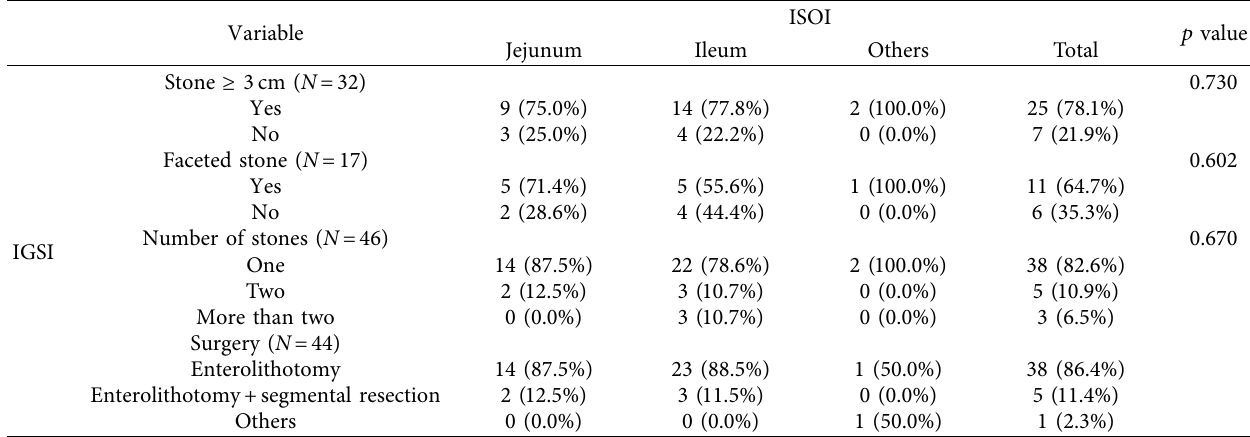
Figure 3: Time of recurrence, (a) ISOI ( p � 0 . 73 ) , (b) number of stones ( p � 0 . 27 ) , (c) age groups in years ( p � 0 . 96 ) , and (d) size of stones ( p � 0 . 18 ) . Table 2: ISOI and clinical characteristics of patients in IGSI and